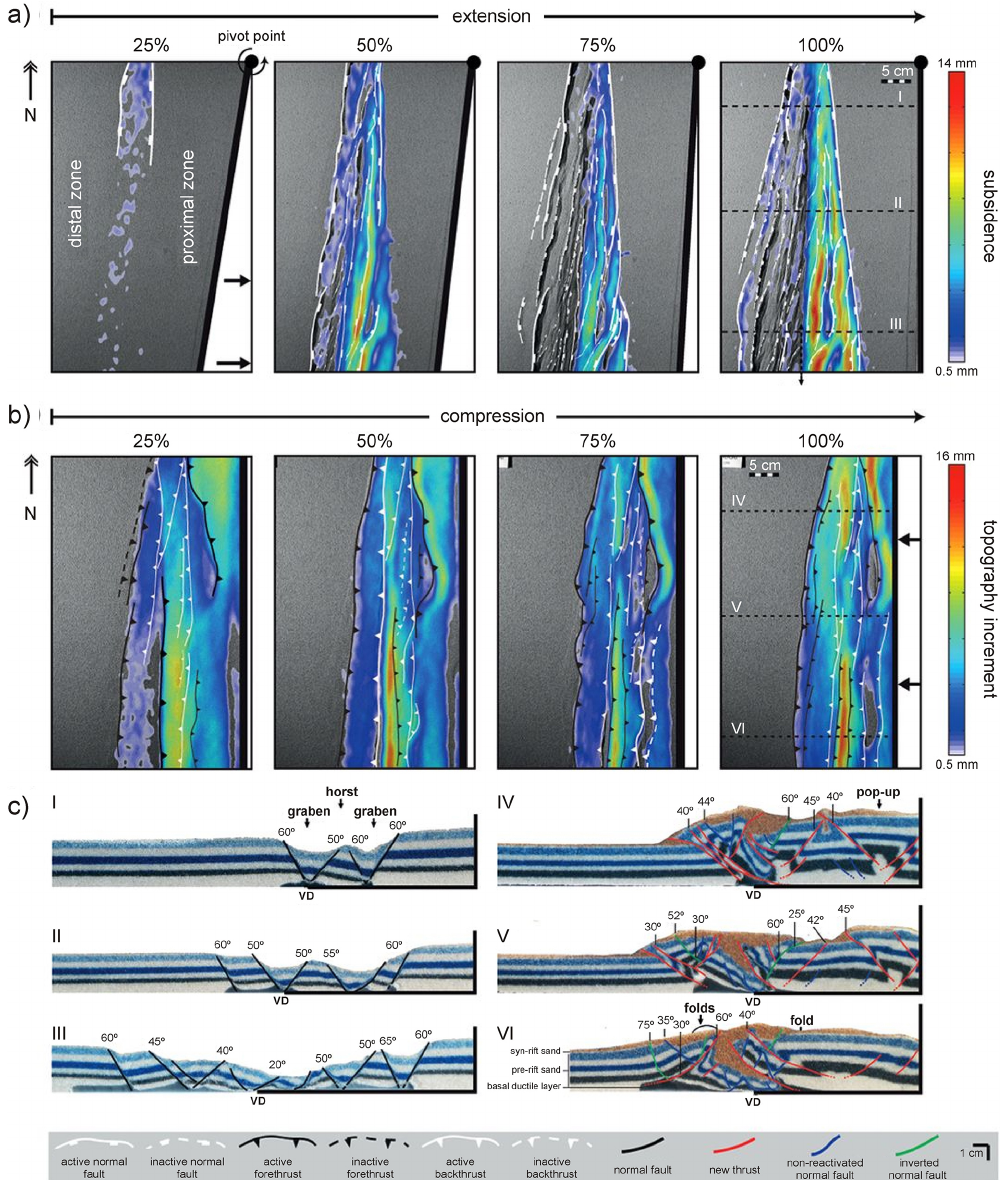
Figure 16. Rotational inversion model. (a) Extensional phase showing active subsidence at different extension percentages. (b) Compres- sional phase showing active topography increment at different shortening percentages. (c) The lines at I, II, and III are cross-sections at the end of initial extension by means of a base plate set-up. The lines are IV, V, and VI are cross-sections after homogeneous shortening by means of a backstop moving into the model. The original model thickness is 3.5cm. Image adopted from Jara et al. (2015) and reproduced with permission from the Geological Society,